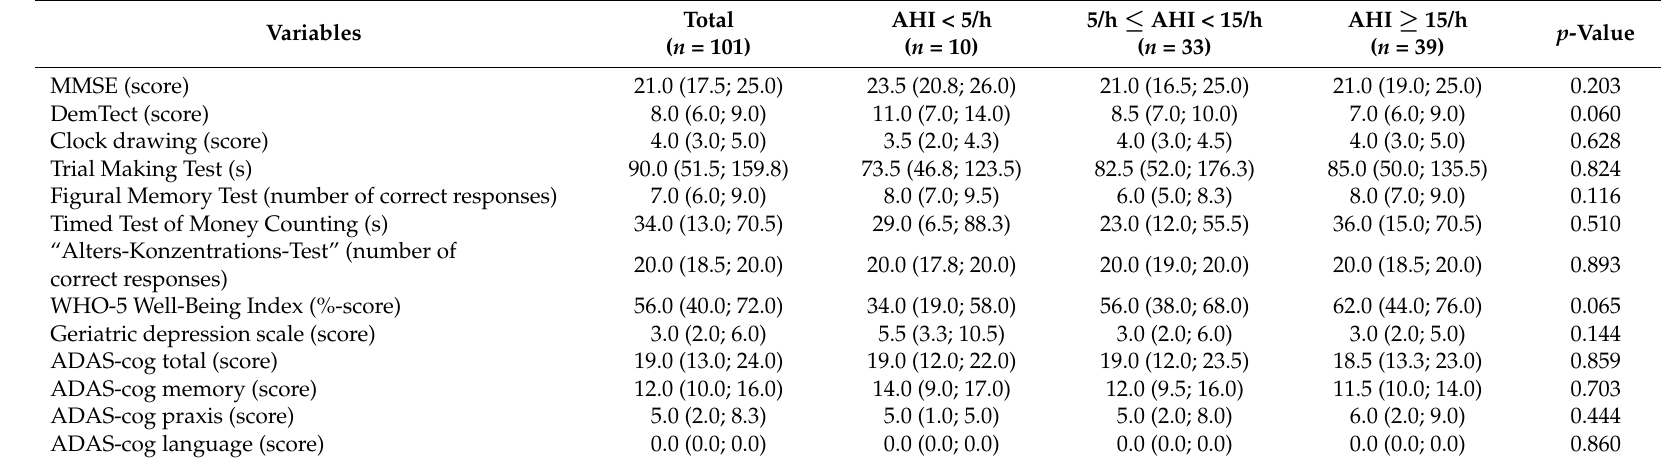
Table 3. Cognitive and emotional function also split by AHI